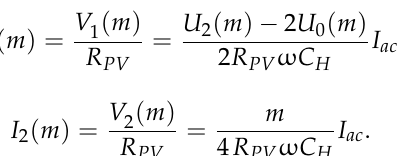
Figure 9. Block diagram of the whole PV control scheme. RCC: ripple correlation control.